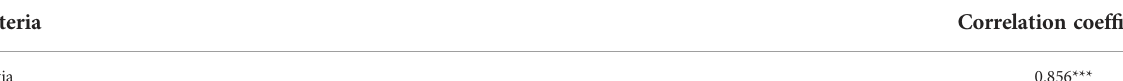
TABLE 1 Correlation coef fi cients between acupuncture treatment and differential bacteria at the family level, *0.01< P ≤ 0.05, **0.001< P ≤ 0.01, *** P ≤ 0.001.